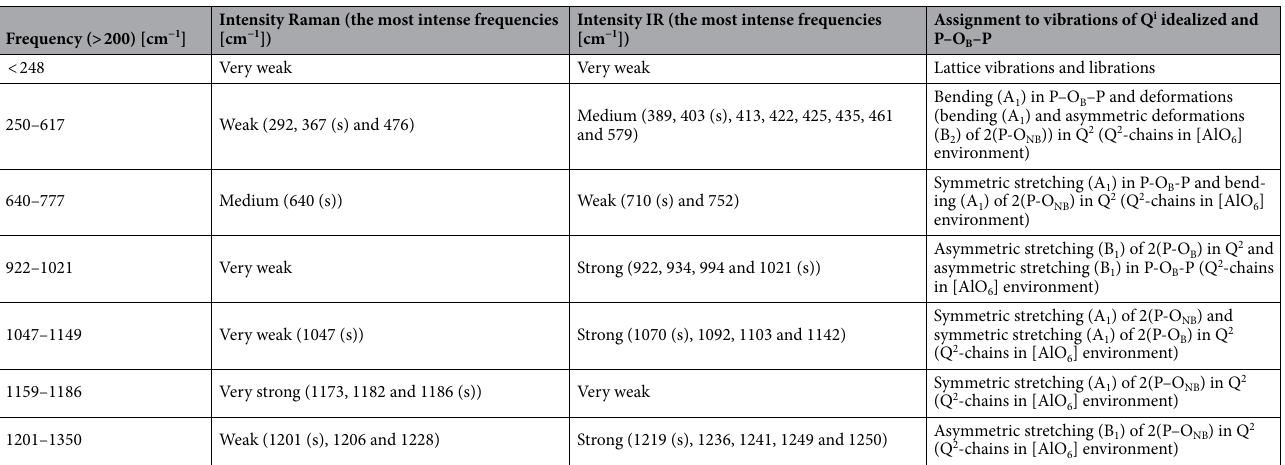
Frequency (> 200) [cm −1